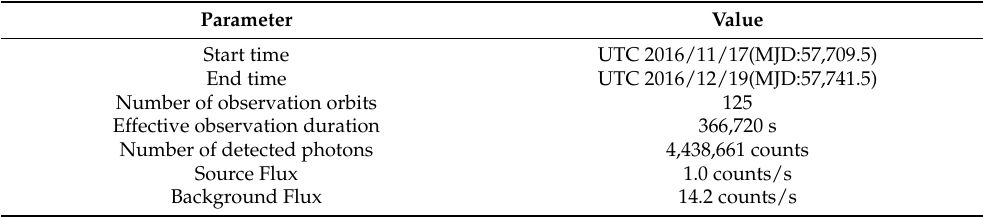
Table A2. Statistics of Crab observation data.